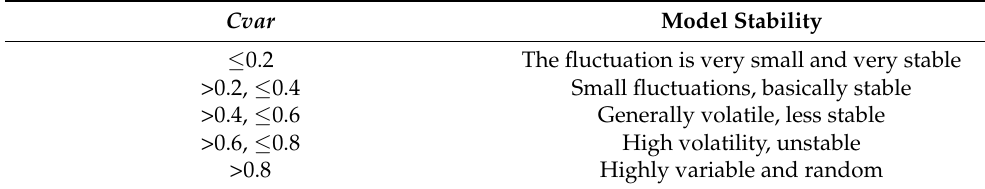
Table 2. Model stability quantization table. Cvar Model Stability ≤ 0.2 The fluctuation is very small and very stable >0.2, ≤ 0.4 Small fluctuations, basically stable >0.4, ≤ 0.6 Generally volatile, less stable >0.6, ≤ 0.8 High volatility, unstable >0.8 Highly variable and random